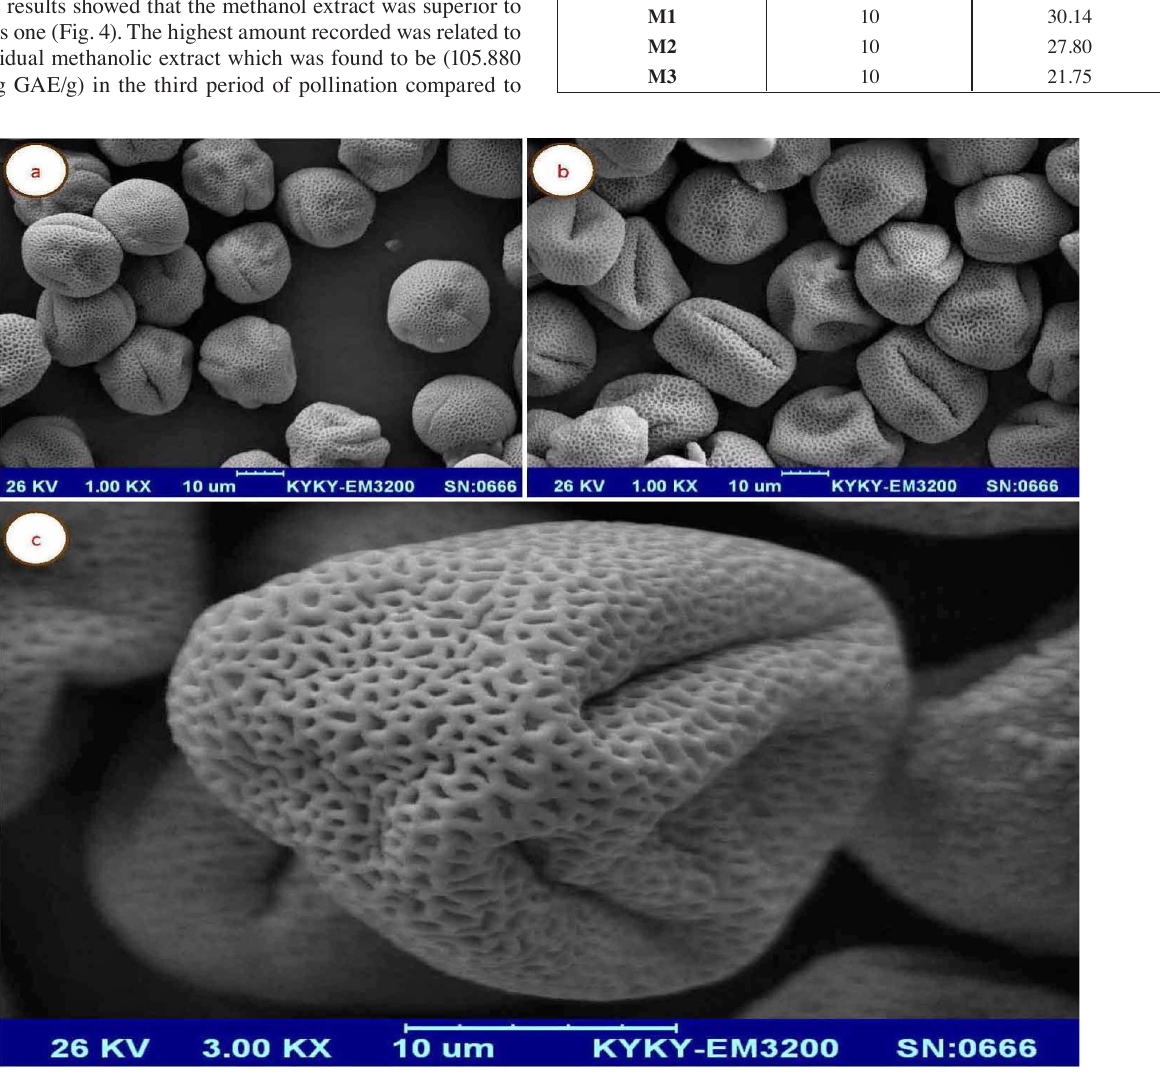
Fig. 3: The purity of both (H and M) pollen grains samples was checked by scanning electron microscopy (a, b). Scanning micrograph of a F. excelsior maturation in H and M phenotypes pollen grains F. excelsior mature pollen grain with three pores (c).